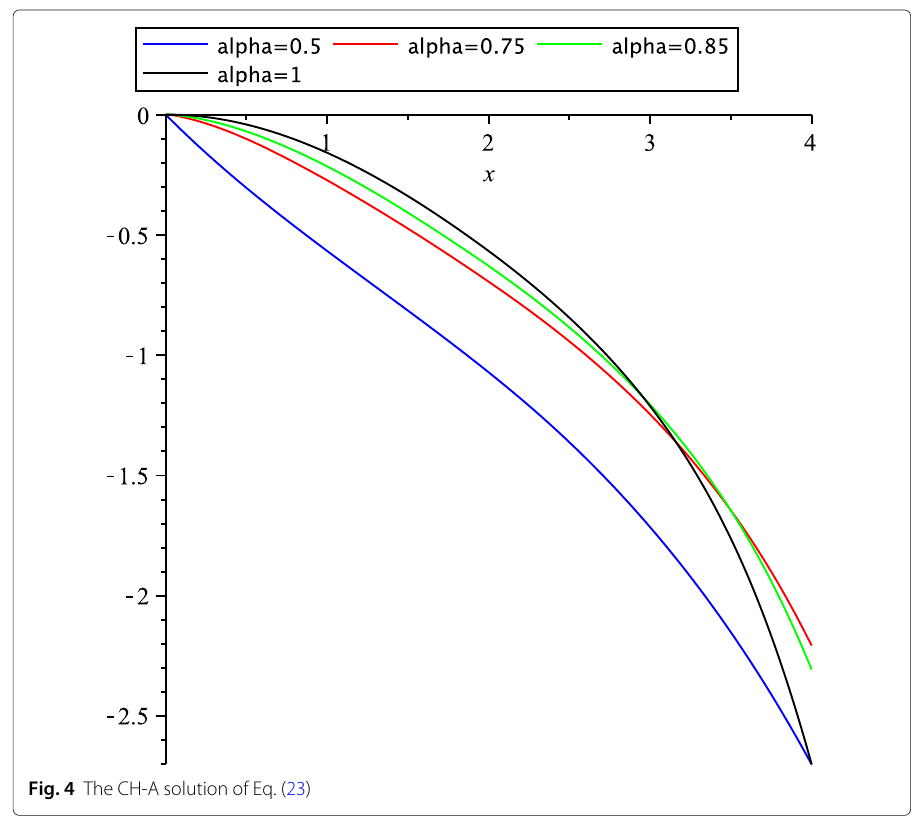
Fig. 4 The CH-A solution of Eq.